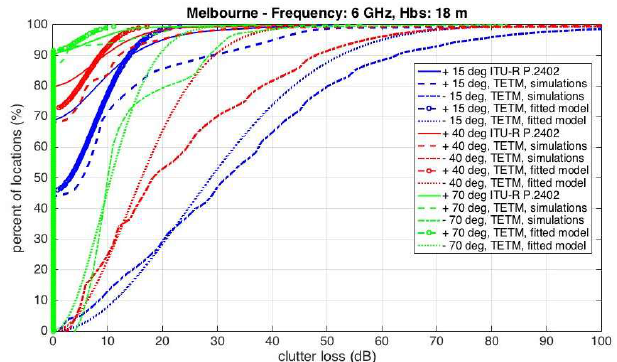
Figure 14. Clutter loss cumulative distributions: comparison between the proposed model and the